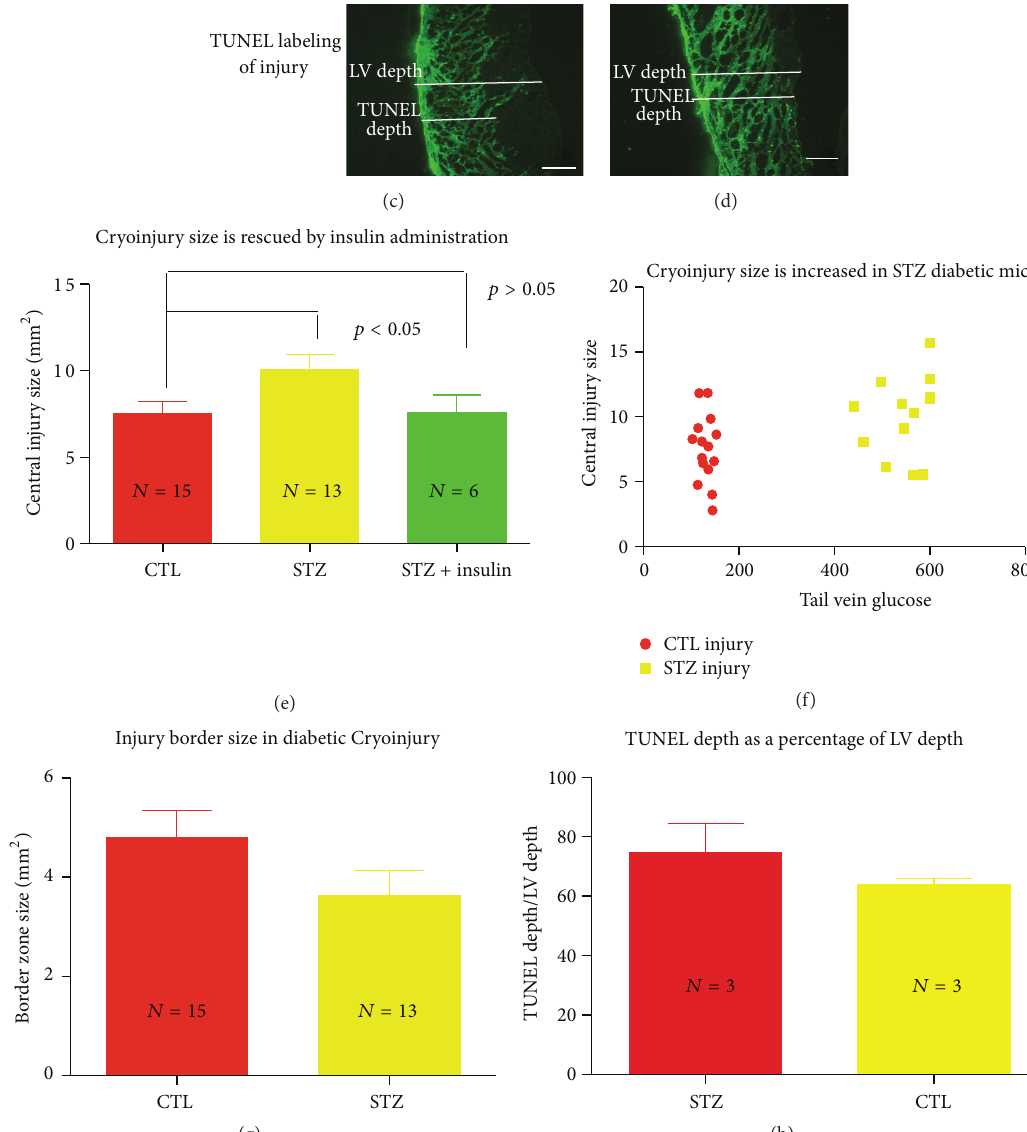
Figure 1: Cryoinjury size is increased in the STZ diabetic mouse. TTC stained control (a) and STZ diabetic (b) rat hearts 48 hrs after cryoinjury. TUNEL labeling of sections from control (c) and STZ diabetic (d) rat ventricles 48 hrs after cryoinjury. Epicardial injury area is increased in the STZ diabetic rodent hearts 48hrs after cryoinjury and this change is rescued by administration of insulin (e, f). There are trends of decreased width of injury border zone (g) and increased TUNEL labeling (h) in the diabetic heart compared to controls. Spaced bars on (a) = 1mm. Scale Bar (c, d) = 500 𝜇